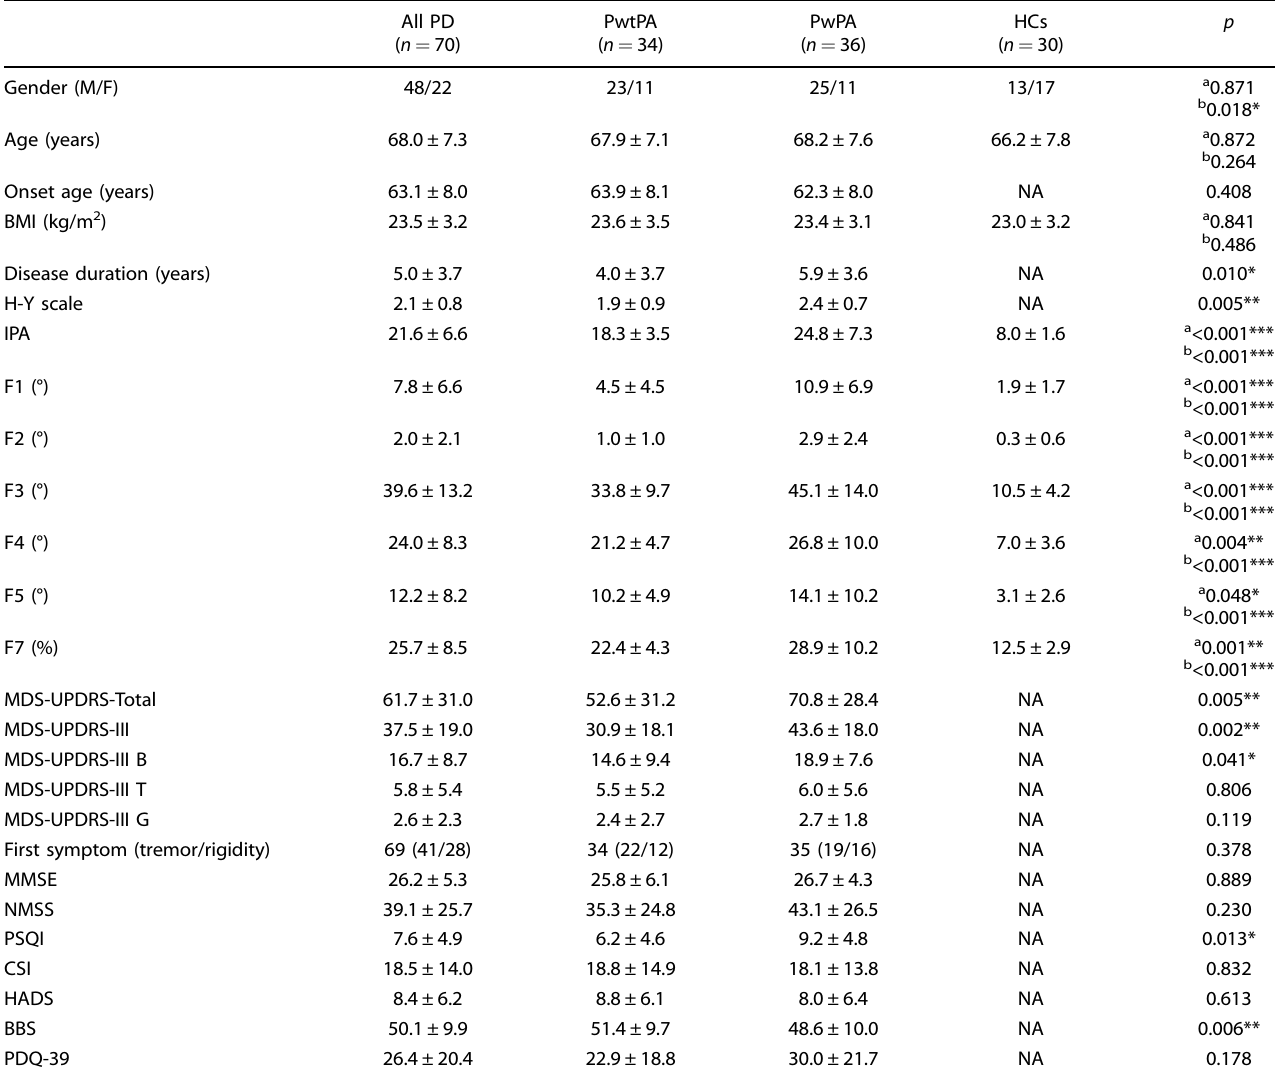
Table 1. Demographic and clinical characteristics of the